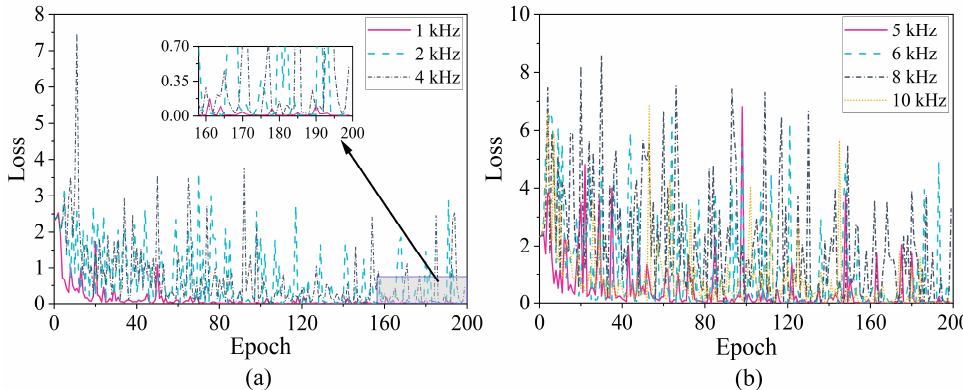
Figure 19. The validation loss of dataset B, ( a ) 1 kHz, 2 kHz, 4 kHz, ( b ) 5 kHz, 6 kHz, 8 kHz, and 10 kHz.